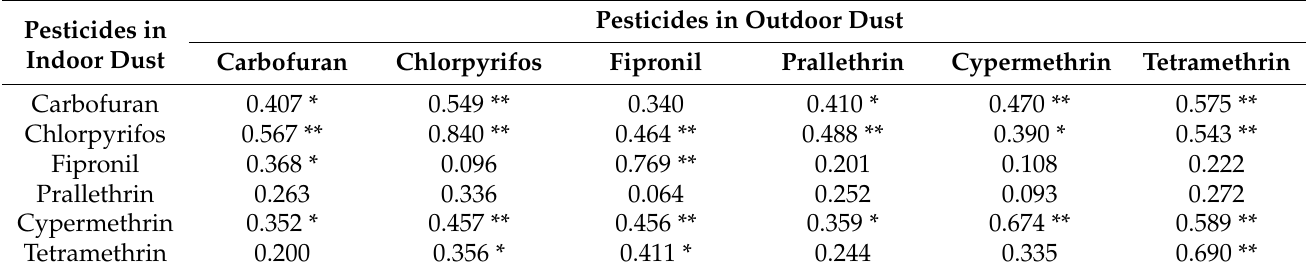
Table 4. Coefficients of Spearman correlations between pesticide concentrations of indoor and outdoor dust. Pesticides in